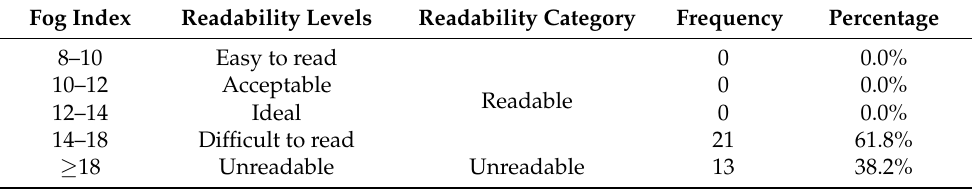
Table 4. Fog index score